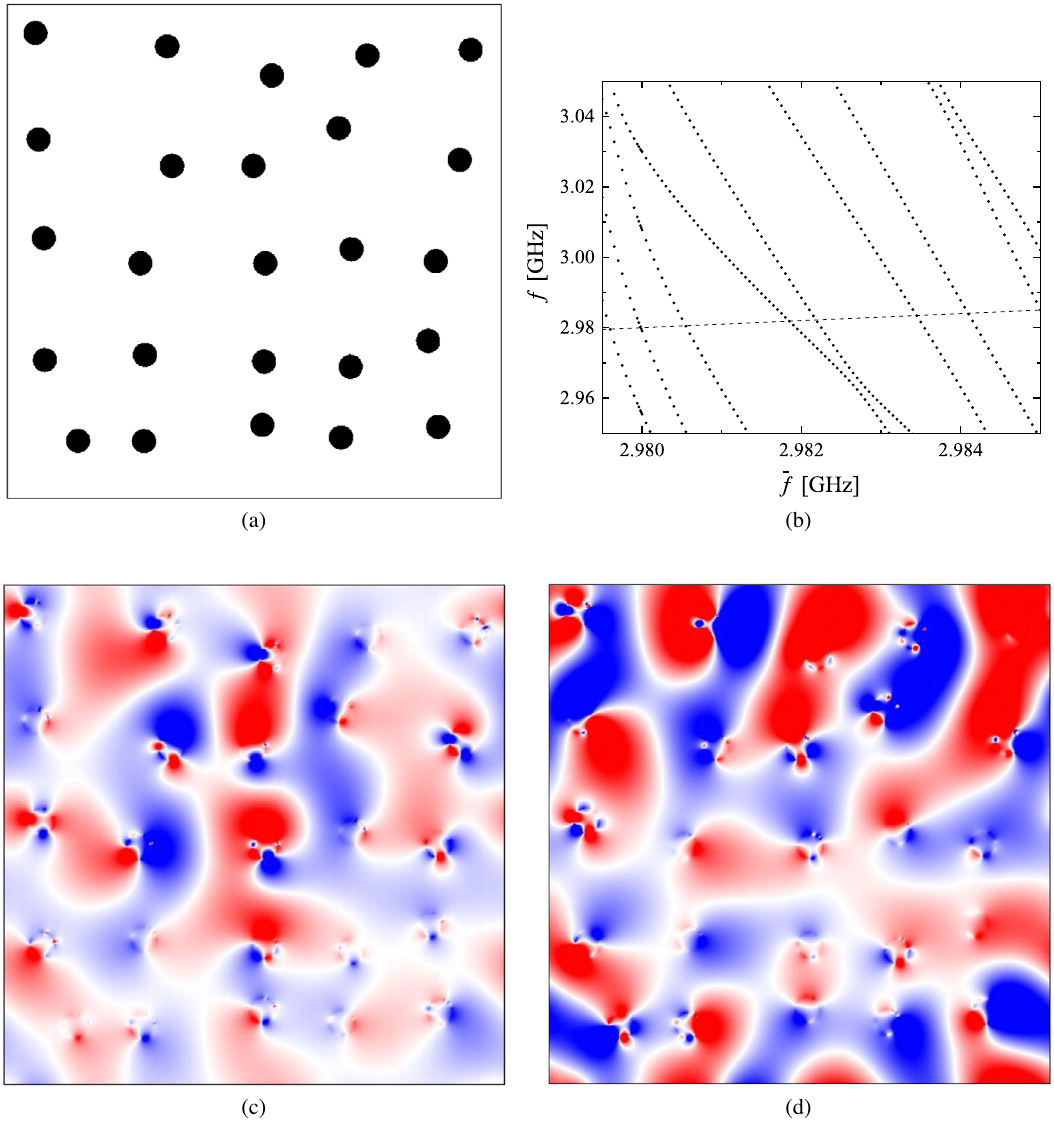
Fig. 4. (a) Supercell containing metamaterial rods arranged in square lattice with positional disorder and eigenmodes with eigenfrequencies. (b) Frequency analysis by self-consistent FDFD method (c) f = 2.97998 GHz, and (d) f = 2.99896